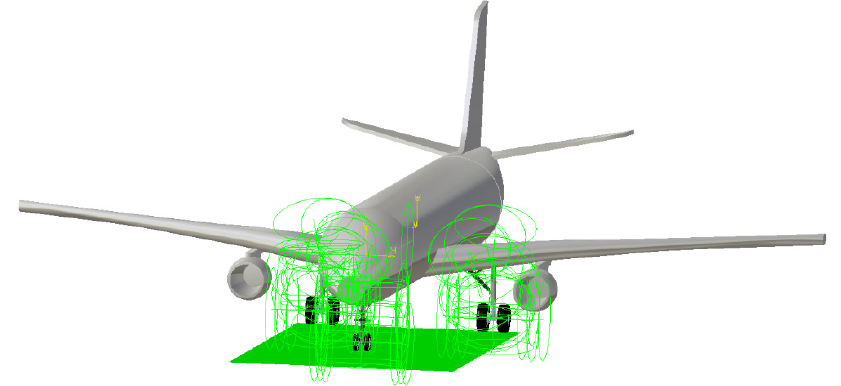
Figure 5. MBD model of aircraft taxiing. Table 3. Main parameters of airframe and landing